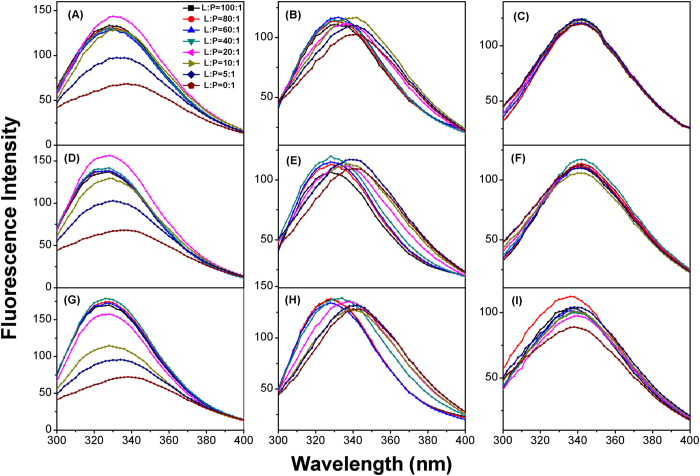
Tryptophan fluorescence emission spectra of the peptides with LUVs model membranes at 25 °C.Fluorescence spectra of MC1-1 in the presence of PG/CL (3:1) (A), PG/PE/CL (2:7:1) (B) and PC/Ch (10:1) (C) liposomes. Fluorescence spectra of MC1-2 in the presence of PG/CL (3:1) (D), PG/PE/CL (2:7:1) (E) and PC/Ch (10:1) (F) lipsomes. Fluorescence spectra of MC1-3 in the presence of PG/CL (3:1) (G), PG/PE/CL (2:7:1) (H) and PC/Ch (10:1) (I) lipsomes.